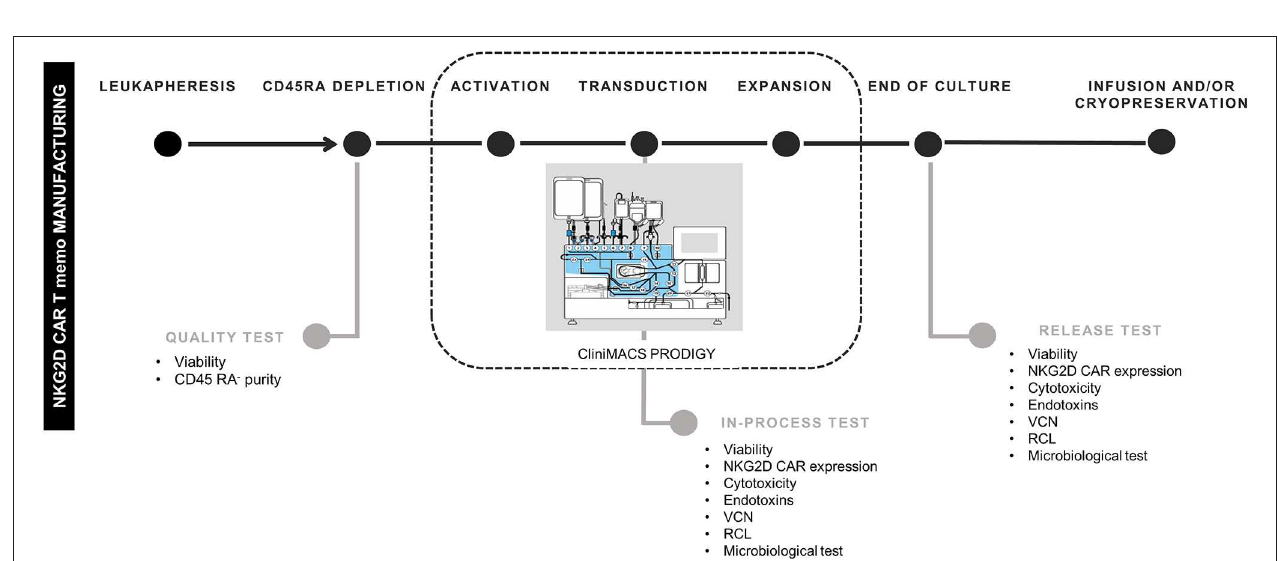
FIGURE 1 | Schema of NKG2D CAR memory T-cell manufacturing process. NKG2D, Natural Killer Group 2D; CAR, chimeric antigen receptor. The schema of CliniMACS Prodigy is Copyrighted © 2015 by Miltenyi Biotec GmbH, used with permission.